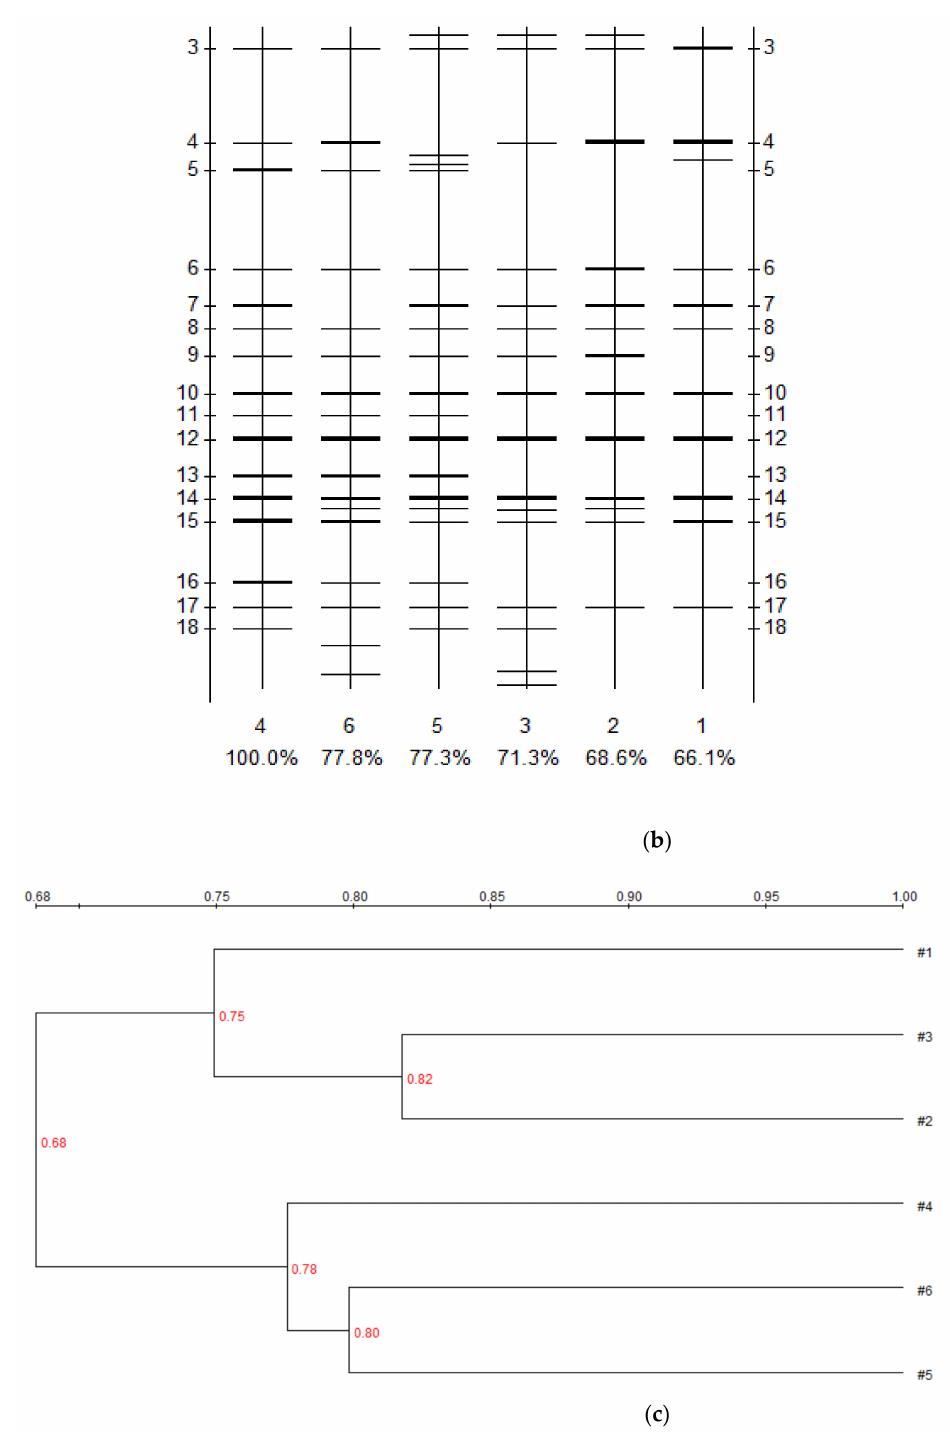
Figure 6. Fingerprint of DGGE and analyzed result in the soil with different treatments on the 210th day. ( a ) DNA electrophoresis fingerprint of DGGE; ( b ) diagram of compare lane images; ( c ) UPGAMA of phylogenetic tree. 210-1~210-6: S + G + D + B-210, S + G + D-210, S + G-210, S + D + B-210, S + D-210,